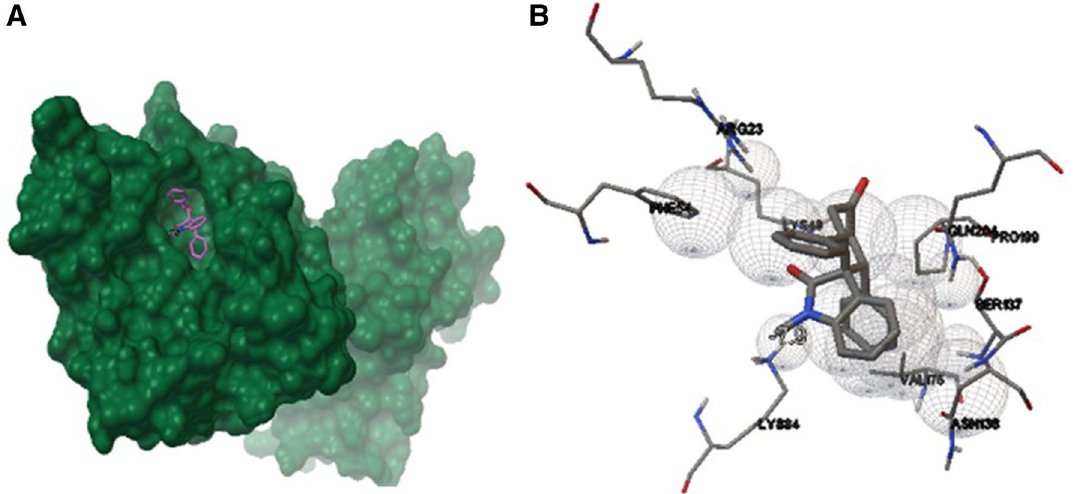
Figure 3. Interaction between cis -spirooxindole 2 with ( A ) OPRT domain of the LdUMPS (PDB ID: 2WNS) and ( B ) residual amino acids of the active site, which include Arg23, Phe54, Lys84, Asn138, Val175, Ser137, Pro199, Gln204, and Lys49. The figure was drawn using UCSF chimera 1.8 (https:// www. cgl. ucsf. edu/ chime ra) and AutoDockTools version 1.5.6 (http:// autod ock. scrip ps. edu) 38,39